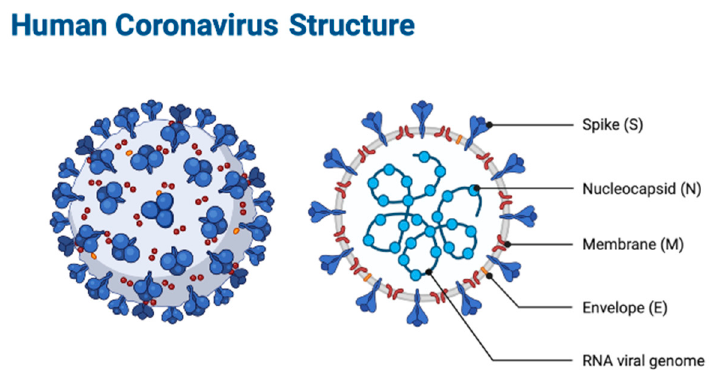
Figure 1. Structure of human coronavirus: the spike (S), envelope (E), membrane (M), and nucleocapsid (N) proteins. Created with BioRender (https://biorender.com/) [13].